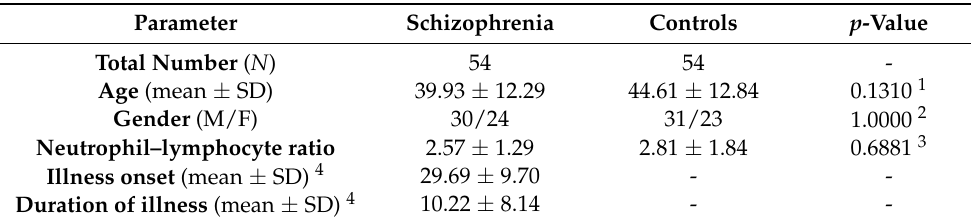
Table 1. Clinical and demographic characteristics of participants. Legend: 1 Mann–Whitney U-test p -value; 2 Fisher’s exact test p -value; 3 unpaired two-tailed t -test; 4 years. PANSS: positive and negative syndrome scale; PANSS positive and negative ranges: 7–49; PANSS general range: 16–112; PANSS total range: